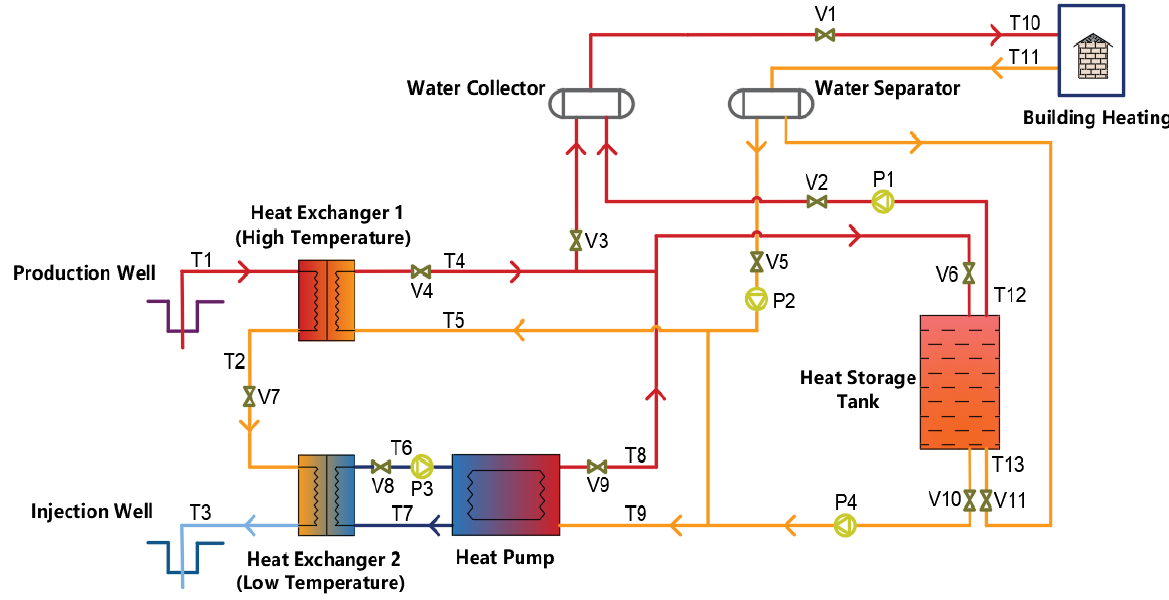
Figure 2. Energy storage – geothermal coupled heating system.